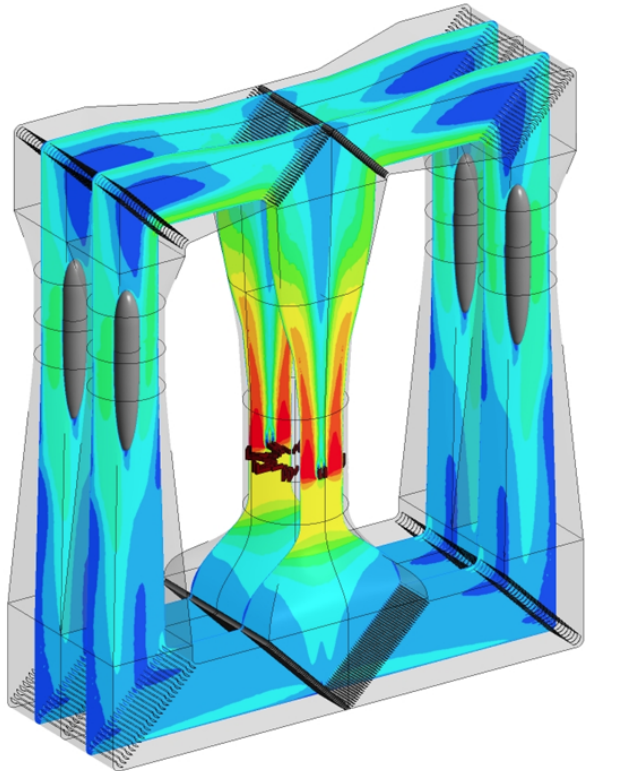
Figure 1. Computational Fluid Dynamics (CFD) simulation for a double-loop wind